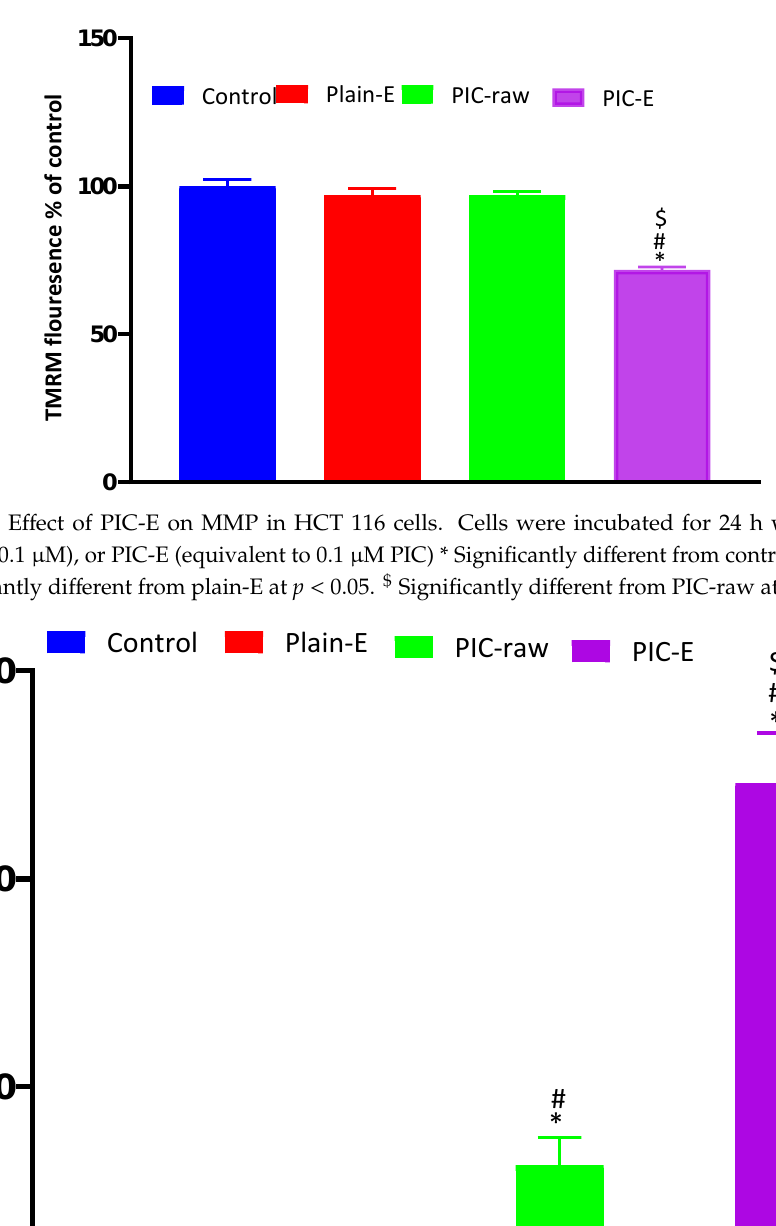
Figure 9. E ff ect of PIC-E on cleaved caspase-3 content in HCT 116 cells. Cells were incubated for 24 h with plain-E, PIC-raw (0.1 µ M), or PIC- E (equivalent to 0.1 µ M PIC) * Significantly di ff erent from control at p < 0.05. # Significantly di ff erent from plain-E at p < 0.05. $ Significantly di ff erent from PIC-raw at p < 0.05.